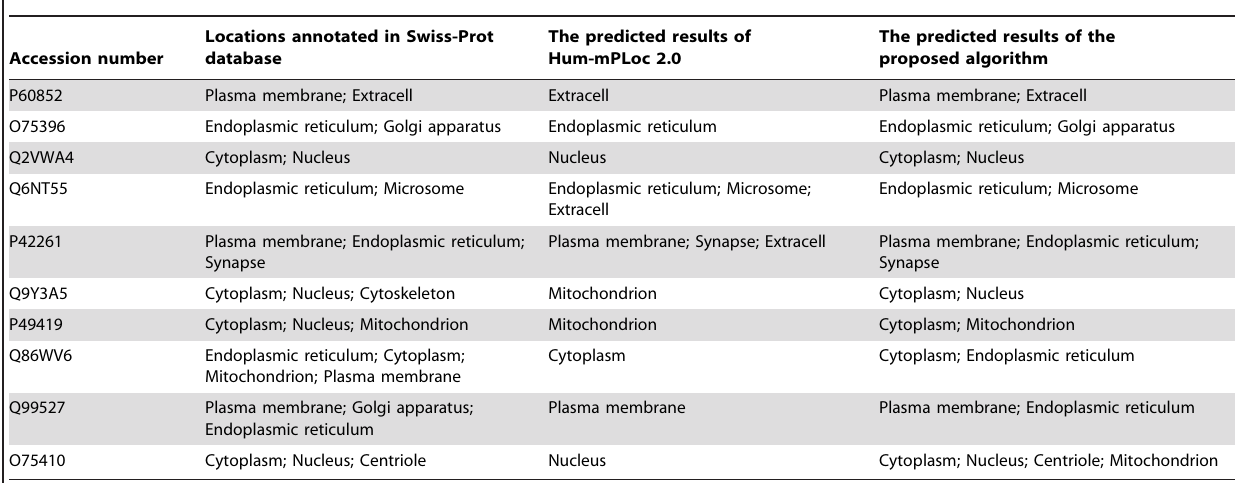
Locations annotated in Swiss-Prot database